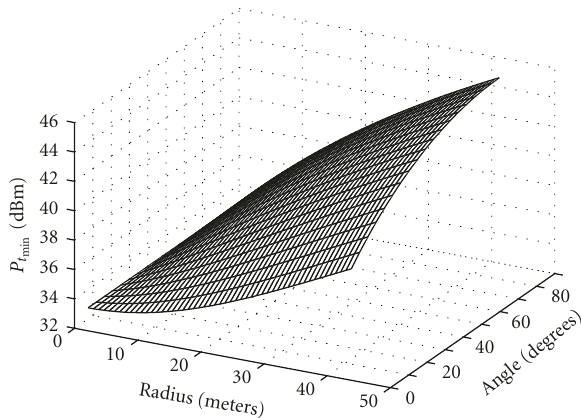
Figure 11: Transmitted power P t for three receivers as a function min of the angle θ and of the radius r ( R = 50 m).